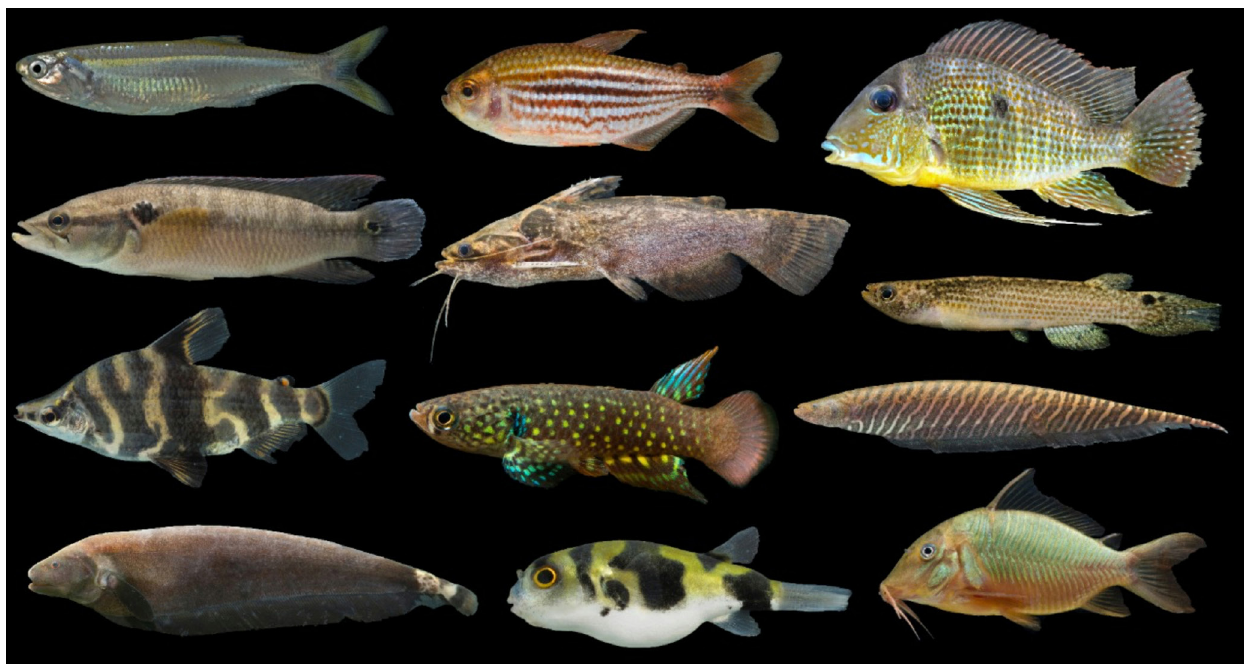
FIGURE 1 | Sample of the phenotypic diversity of Neotropical freshwater fishes. Upper left to lower right: Lycengraulis grossidens (Spix & Agassiz, 1829); Hyphessobrycon hexastichos Bertaco & Carvalho, 2005; Geophagus neambi Lucinda, Lucena & Assis, 2010; Crenicichla lepidota Heckel, 1840; Trachelyopterus galeatus (Linnaeus, 1766); Anablepsoides xinguensis (Costa, 2010); Abramites hypselonotus (Günther 1868);